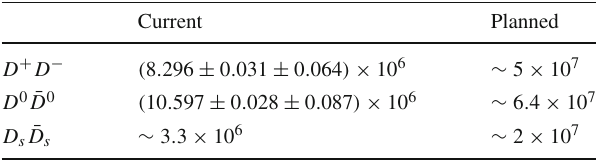
Table 1 The total numbers of D + D − , D 0 ¯ D 0 , D + s D − s pairs from BESIII collaboration, where in the data-taking plan the future data sam- ples will be 6 times as large as the current ones. The number of D ¯ D pair is from Ref. [42]